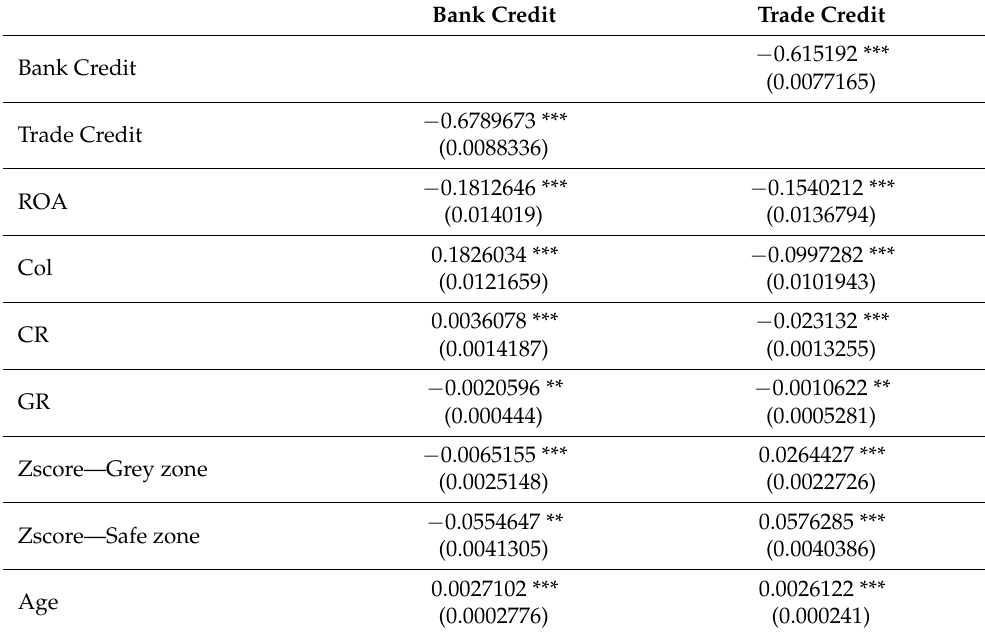
Table 7. Estimated models for analysis of the substitution or complementarity